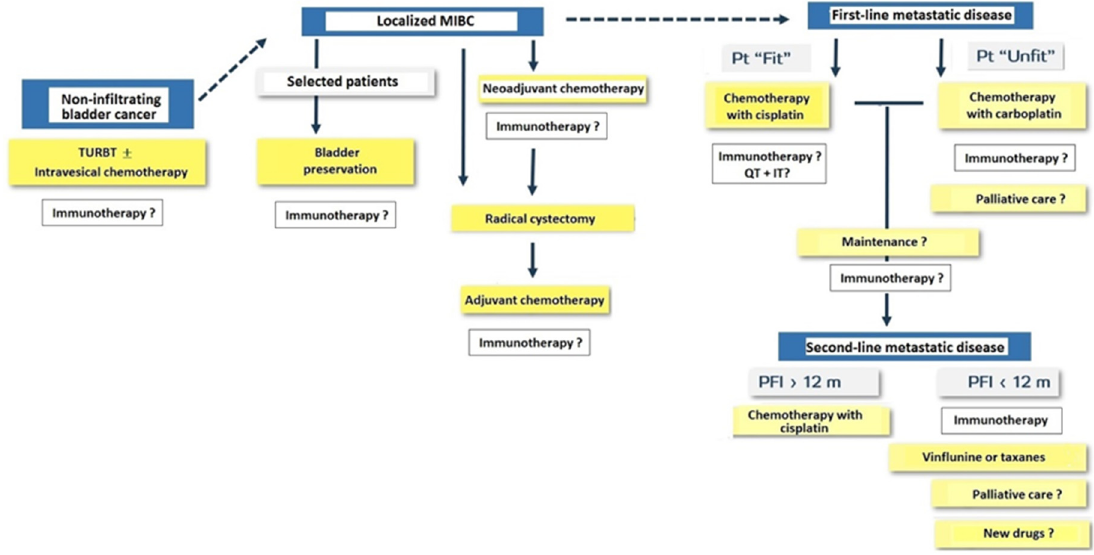
Figure 7. Treatment approach in patients with non-infiltrating bladder cancer, muscle-invasive bladder cancer (MIBC) and metastatic disease (Pt: patient; TURBT: transurethral resection of blad- der tumor; QT: chemotherapy; IT: immunotherapy; PFI: progression-free interval; m: